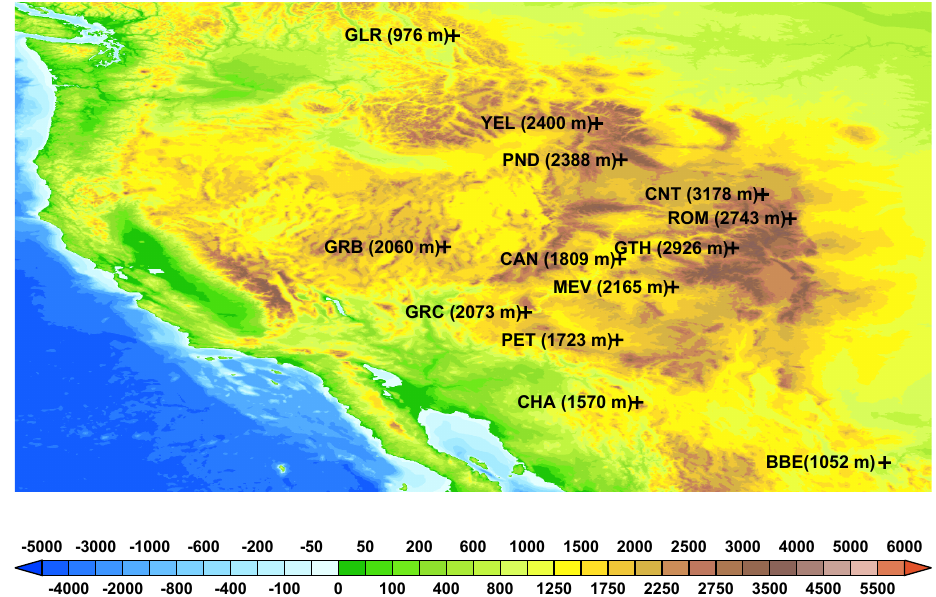
Figure 1. Thirteen CASTNet ozone monitoring sites (Table 2, black pluses) in the US Intermountain West used in this study. Also shown is SLC (Salt Lake City, Utah) urban site (filled triangle). Altitudes of the sites are also labeled. The underlying figure shows terrain elevations (m) of the western